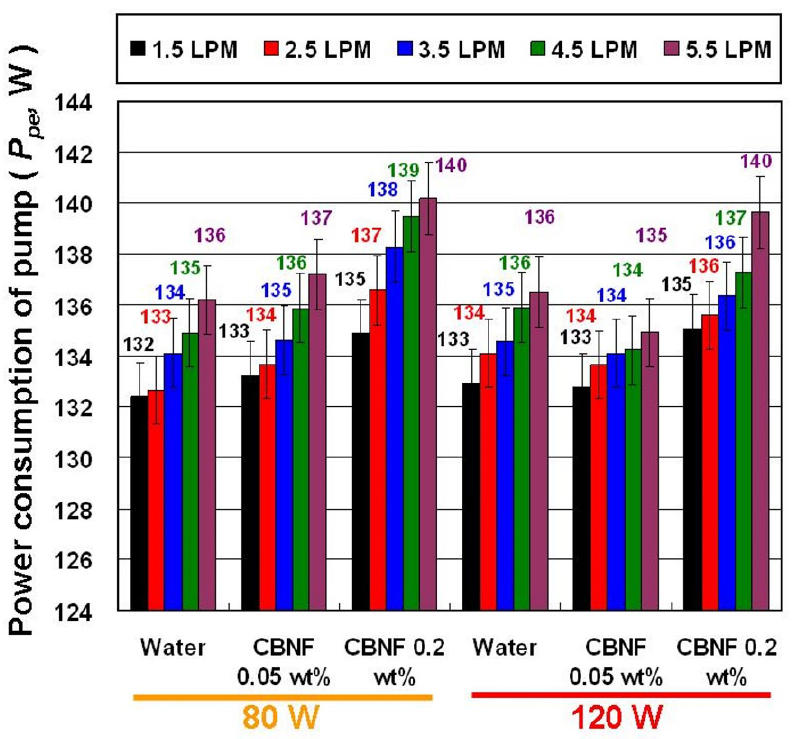
Figure 6. The P pe of test samples for THE system at various experimental parameters.